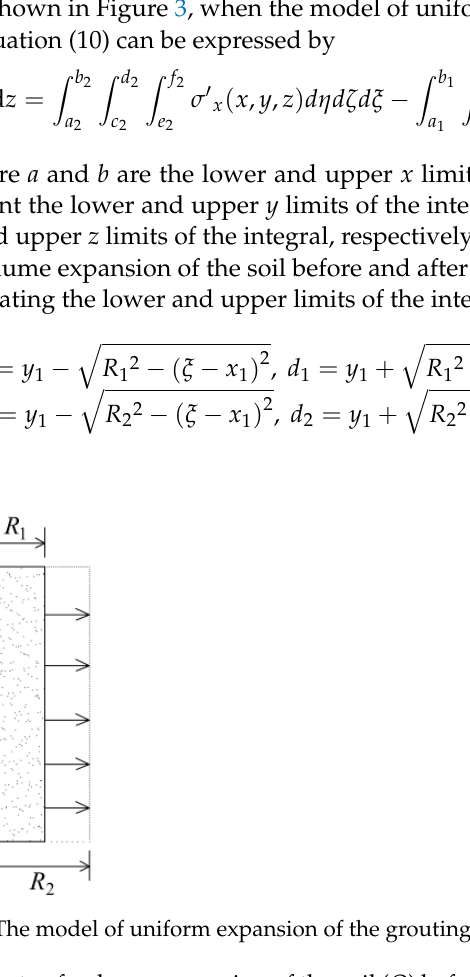
Figure 2. The mechanical calculation model. As shown in Figure 3, when the model of uniform expansion of the grouting area is used, Equation (10) can be expressed by